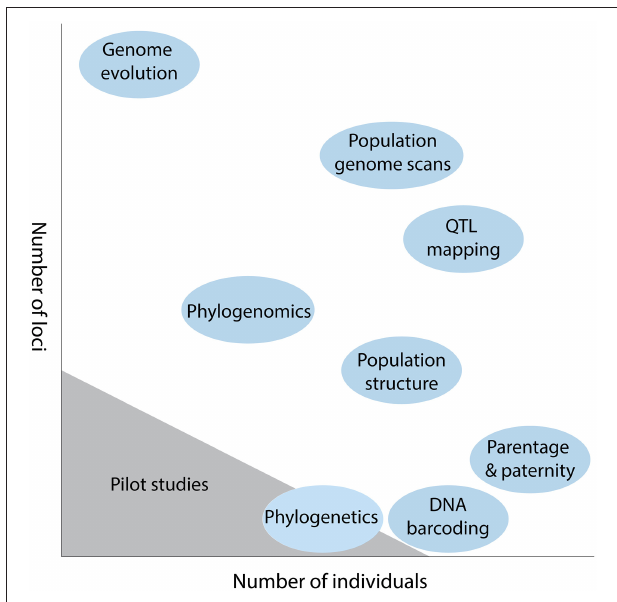
FIGURE 1 | Diagrammatic representation of the trade-off between number of loci and number of individuals in some typical plant genetic studies. The scale of sequencing for pilot studies is also